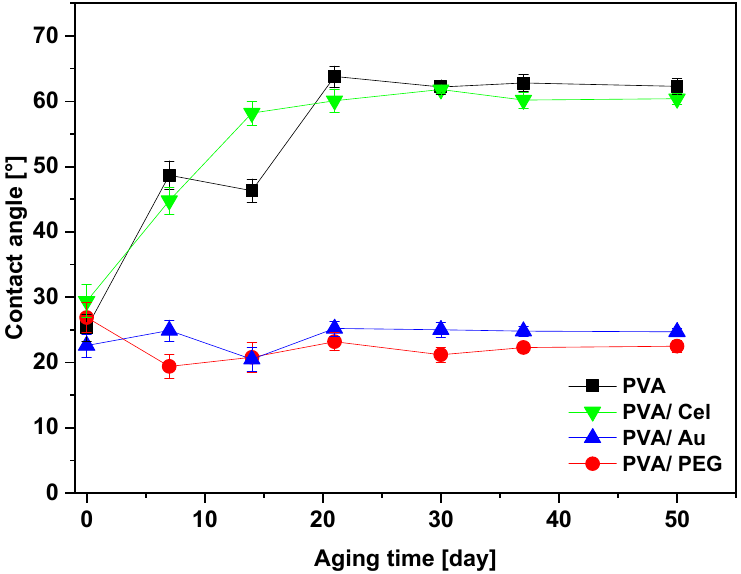
Figure 1. Ageing. Dependence of the water contact angle of plasma-treated PVA foils on the ageing time. The plasma-treated foils were either non-doped (PVA) or were doped with cellulose (PVA / Cel), with poly(ethylene glycol) (PVA / PEG) or with Au nanoparticles in a PEG colloid solution (PVA / Au). Table 1. Values of the contact angles of PVA foils non-treated or treated with plasma and aged for 30 days. The foils were either non-doped (PVA) or were doped with cellulose (PVA / Cel), with poly(ethylene glycol) (PVA / PEG) or with Au nanoparticles in a PEG colloid solution (PVA /